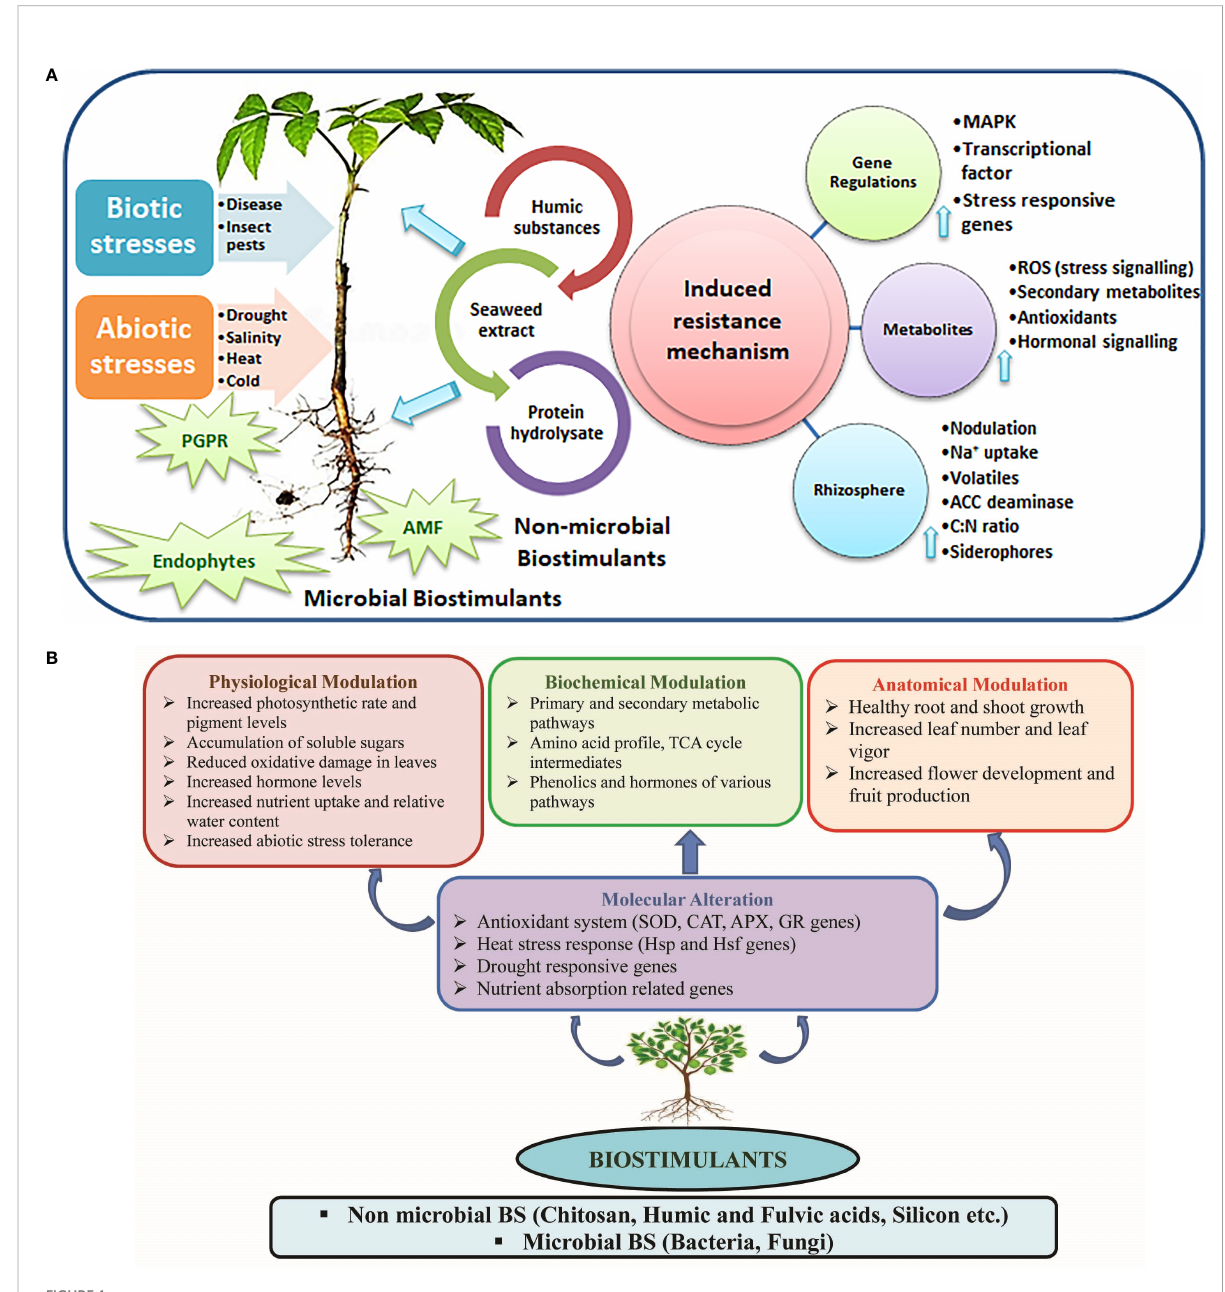
FIGURE 1 (A, B) The role of biostimulants in mitigating the adverse effects of stresses on plants through several mechanisms (molecular alteration, physiological, biochemical, and anatomical